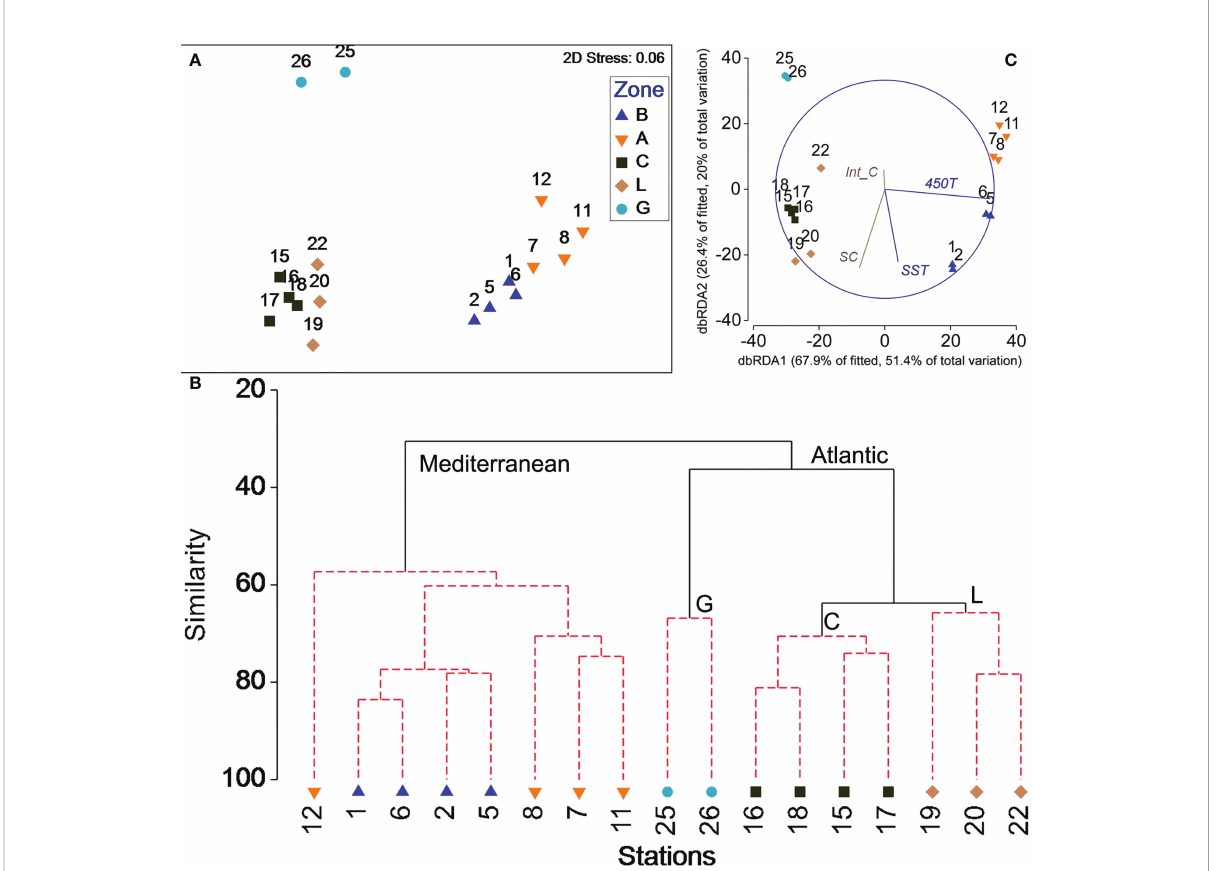
FIGURE 6 Assemblage structure for the 17 stations sampled through the 0-700 m of the water column around the Iberian Peninsula. (A) MDS multi- dimensional scaling, (B) Distance-based redundancy bi-plot showing the relationships between mesopelagic fi sh assemblages and environmental variables (C) Dendrogram of station similarities (continuous black lines denote signi fi cant groups of samples de fi ned by the SIMPROF test). Zone labels: B: Balears, A: Alboran, C: Cadiz, L: Lisboa, G: Galicia). 450T: Temperature at 450 m. SC, Surface Chlorophyll a. SST, Sea Surface Temperature. Int_C, Integrated Chlorophyll a in the upper 200